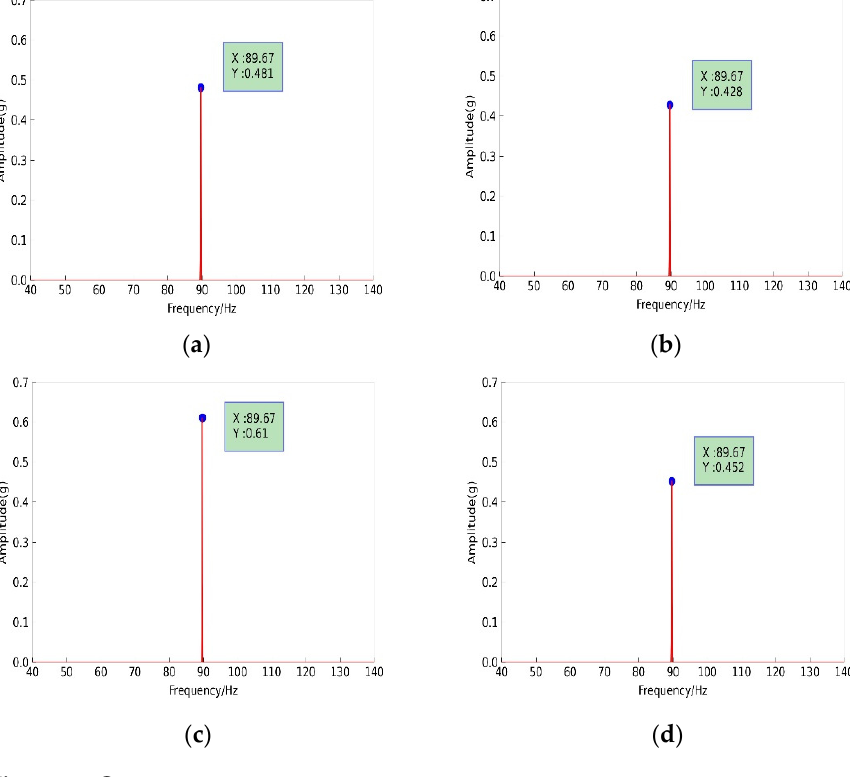
( h ) Figure 11. Vibration response under low-pressure constant-frequency excitation: ( a ) TA18 titanium alloy pipeline; ( b ) Nitronic40 stainless-steel pipeline; ( c ) 6061T6 aluminium alloy pipeline; ( d ) spec- imen no. 1; ( e ) specimen no. 2; ( f ) specimen no. 5; ( g ) specimen no. 6; ( h ) specimen no. 8. 5.2. Experiment to Determine the High-Pressure Fixed-Frequency Harmonic Response of Engine Double Rotors The excitation frequency was set to 270 Hz for the high-voltage rotor, and the accel- eration of the excitation force was 2 g. The vibration response of the straight aviation hy- draulic pipe before and after coating was obtained. A few responses are depicted in detail in Figure 12.